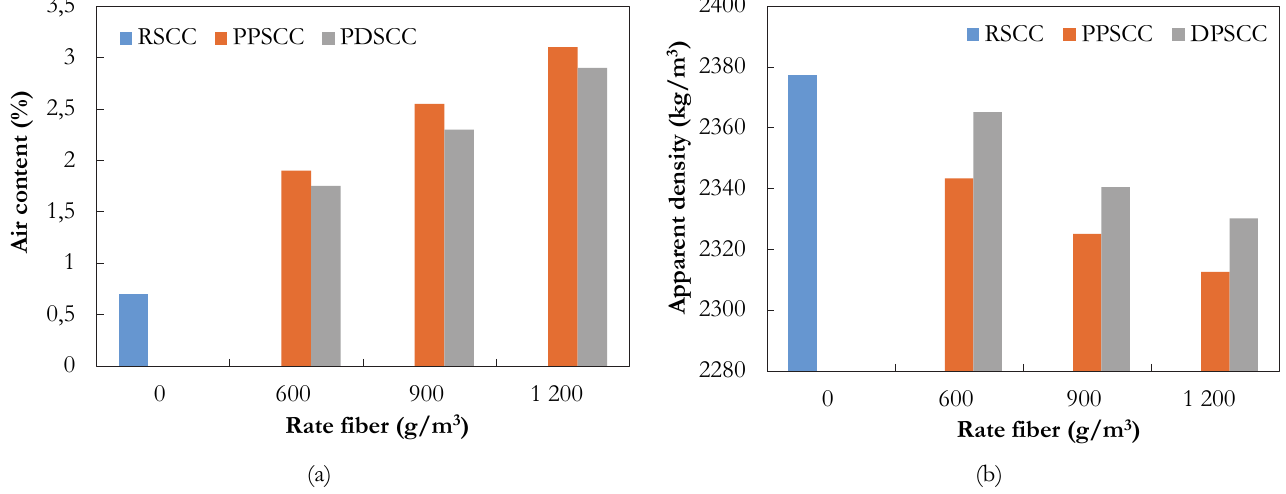
Figure 16: Effect of fiber rate on: (a) air content of SCC and (b) density of